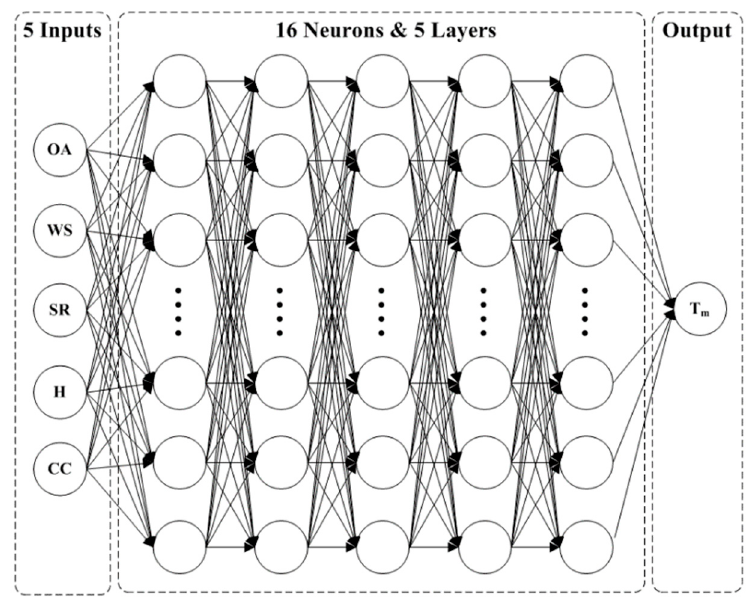
Figure 5. Diagram of the optimized ANN model.